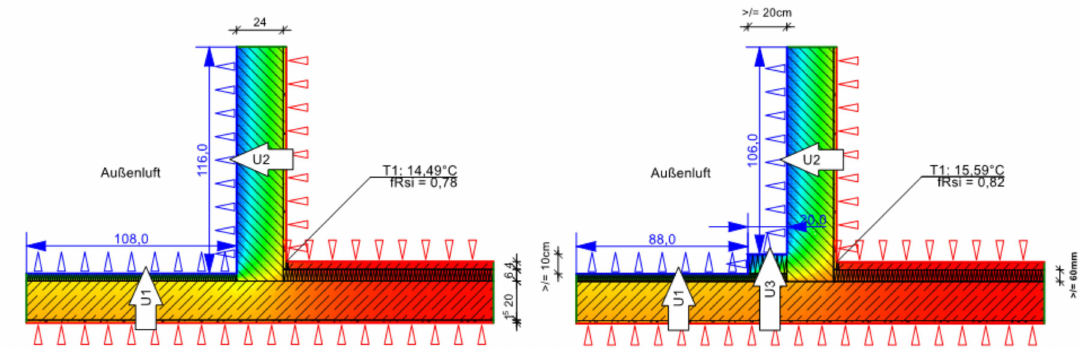
Figure A22. Before and after the thermal bridge retrofit of a staggered story (created with ThermCad thermal bridge simulation calculator). Table A24. Retrofit components and costs of the thermal bridge retrofit of a staggered story [38,39]. Pos. No.